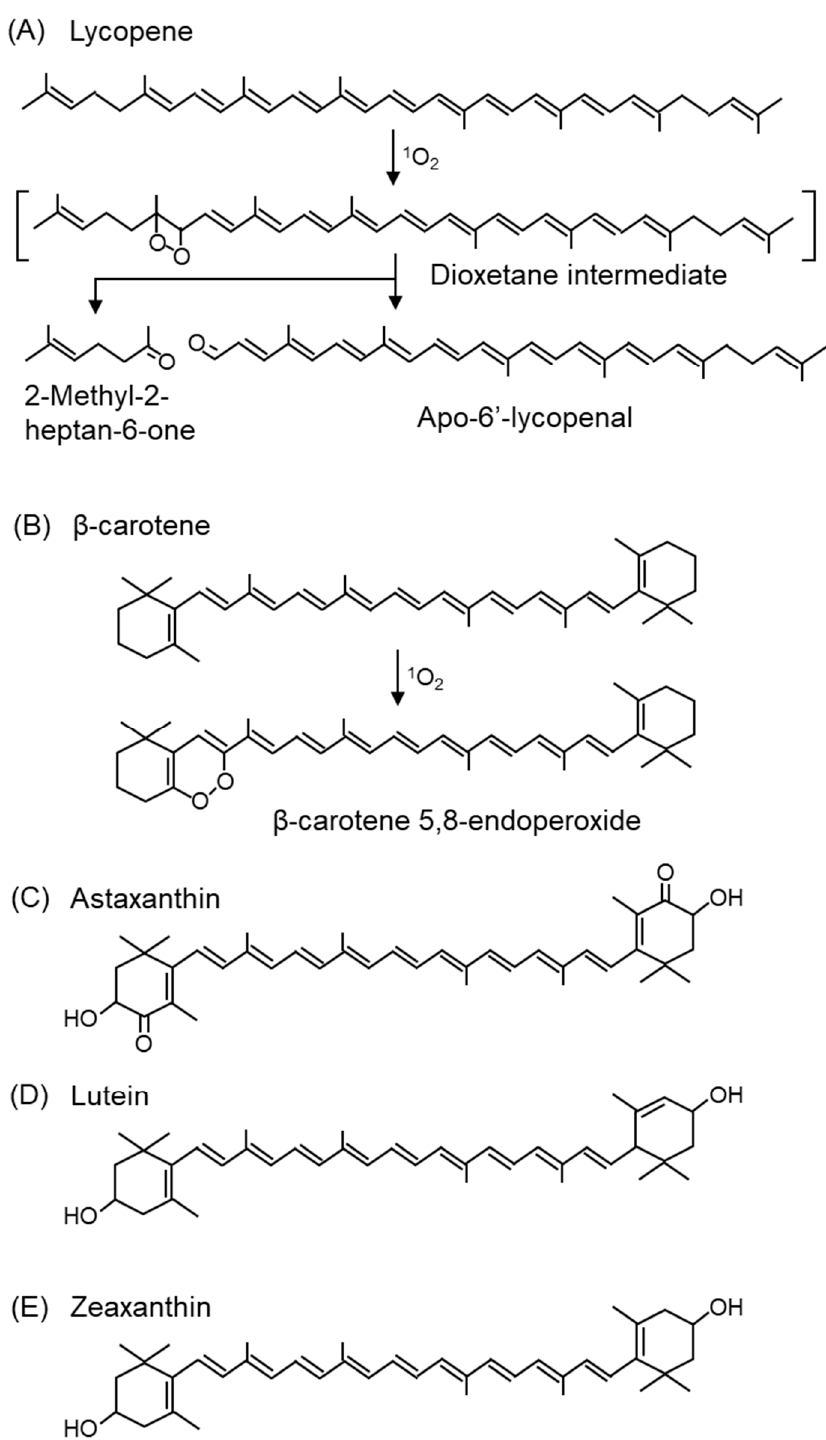
Figure 12. The structures of carotenoid and peroxidation products from lycopene and β -carotene. ( A ) Lycopene, ( B ) β -carotene, ( C ) astaxanthin, ( D ) lutein, ( E ) zeaxanthin. Carotenoids in plants exist in close proximity to chlorophyll in chloroplasts and scav- enge 1 O 2 generated by the photosensitizing effect of chlorophyll during light absorption. Thus, carotenoids have a protective property against light stress in plants. In addition, carotenoids, such as xanthophylls (lutein (Figure 12D) and zeaxanthin (Figure 12E), spe- cifically accumulate in the macula of the retina, which is an organ exposed to light. In